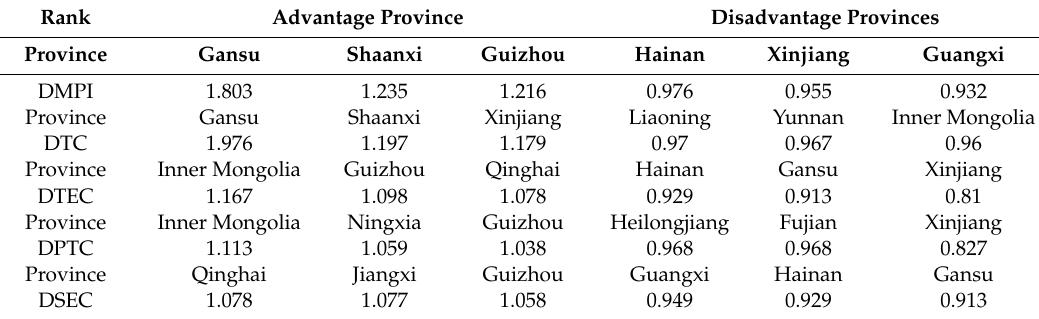
Table 3. Provincial FDI performance